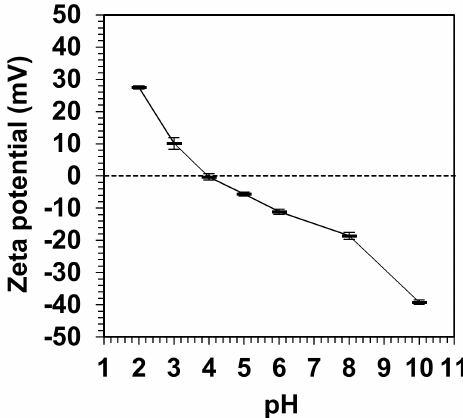
Figure 7. Zeta potential of the simulated soils at different pH value from 2.0 to